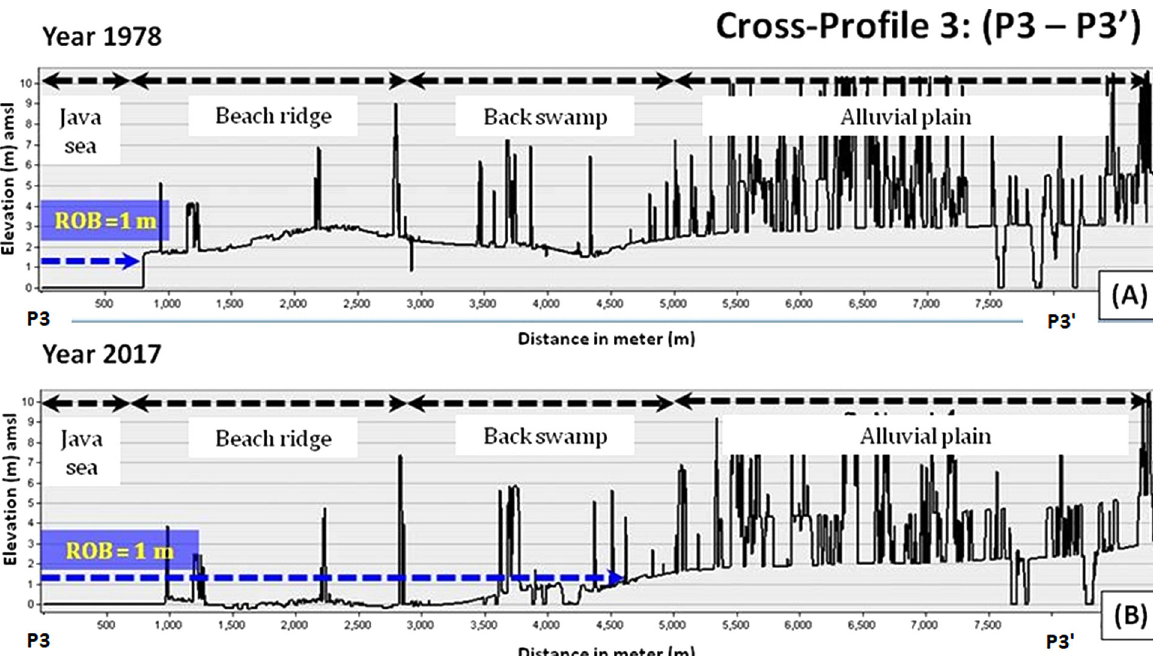
Fig. 10. Comparison results for morphological and topographic condition change from DEM modelling between 1978 and 2017 on cross-profile 3 (P3-P3’) and their implications for vertical tidal flood distribution in coastal landform areas.